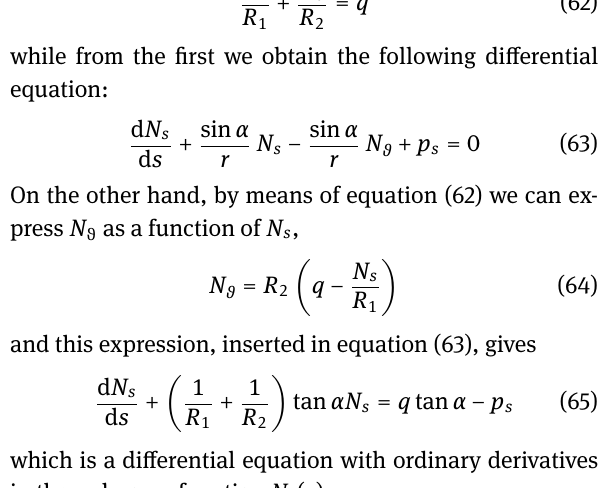
Also in this case the contribution of the third term is due to the greater length of the outermost arc of